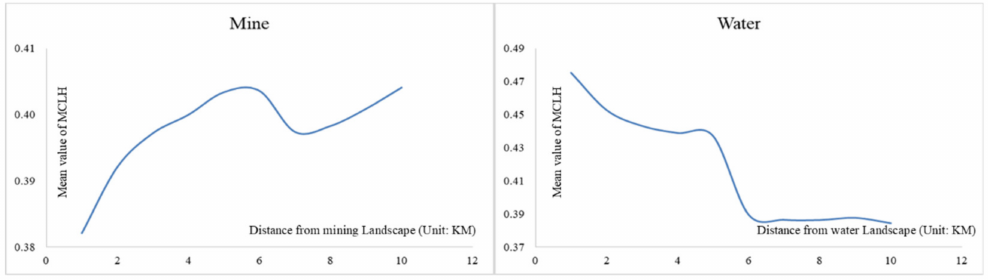
Figure 11. Buffer Analysis of Grassland LEH around Mining and Water Landscape.